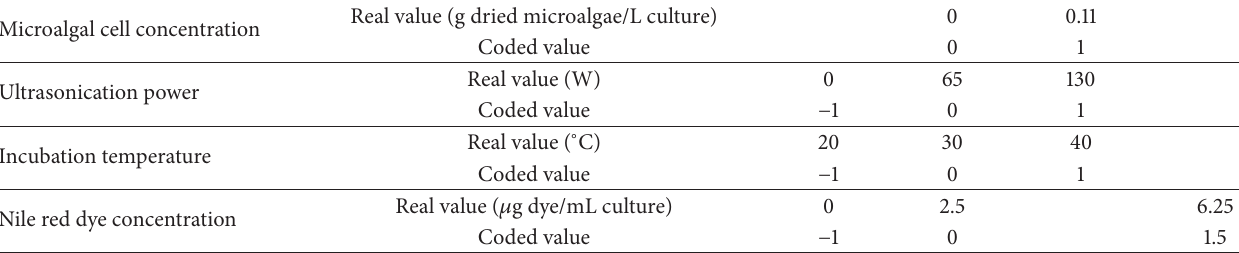
Table 1: Real and coded values of the independent variables investigated in the factorial experimental design. Microalgal cell